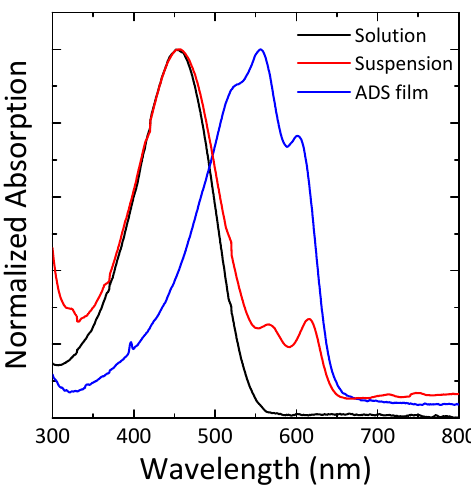
Figure 1. Normalized UV-vis absorption spectra of poly(3-hexylthiophene) (P3HT) solution (black line), suspension (red line) and adsorbing deposition in suspensions (ADS) film (blue line).